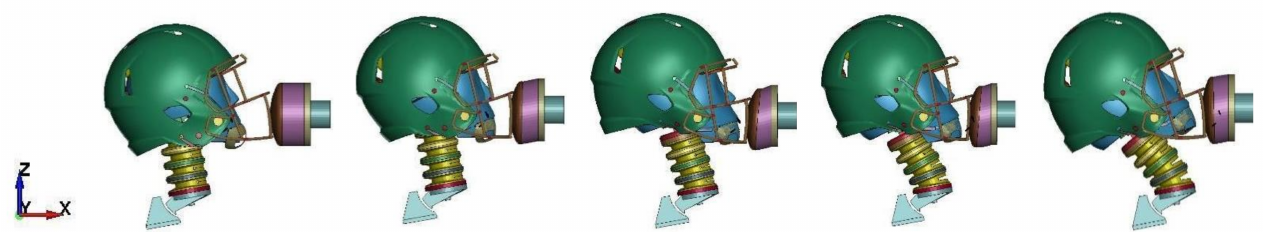
Figure A1. The course of simulation (0–20 ms, 5 ms interval) in configuration